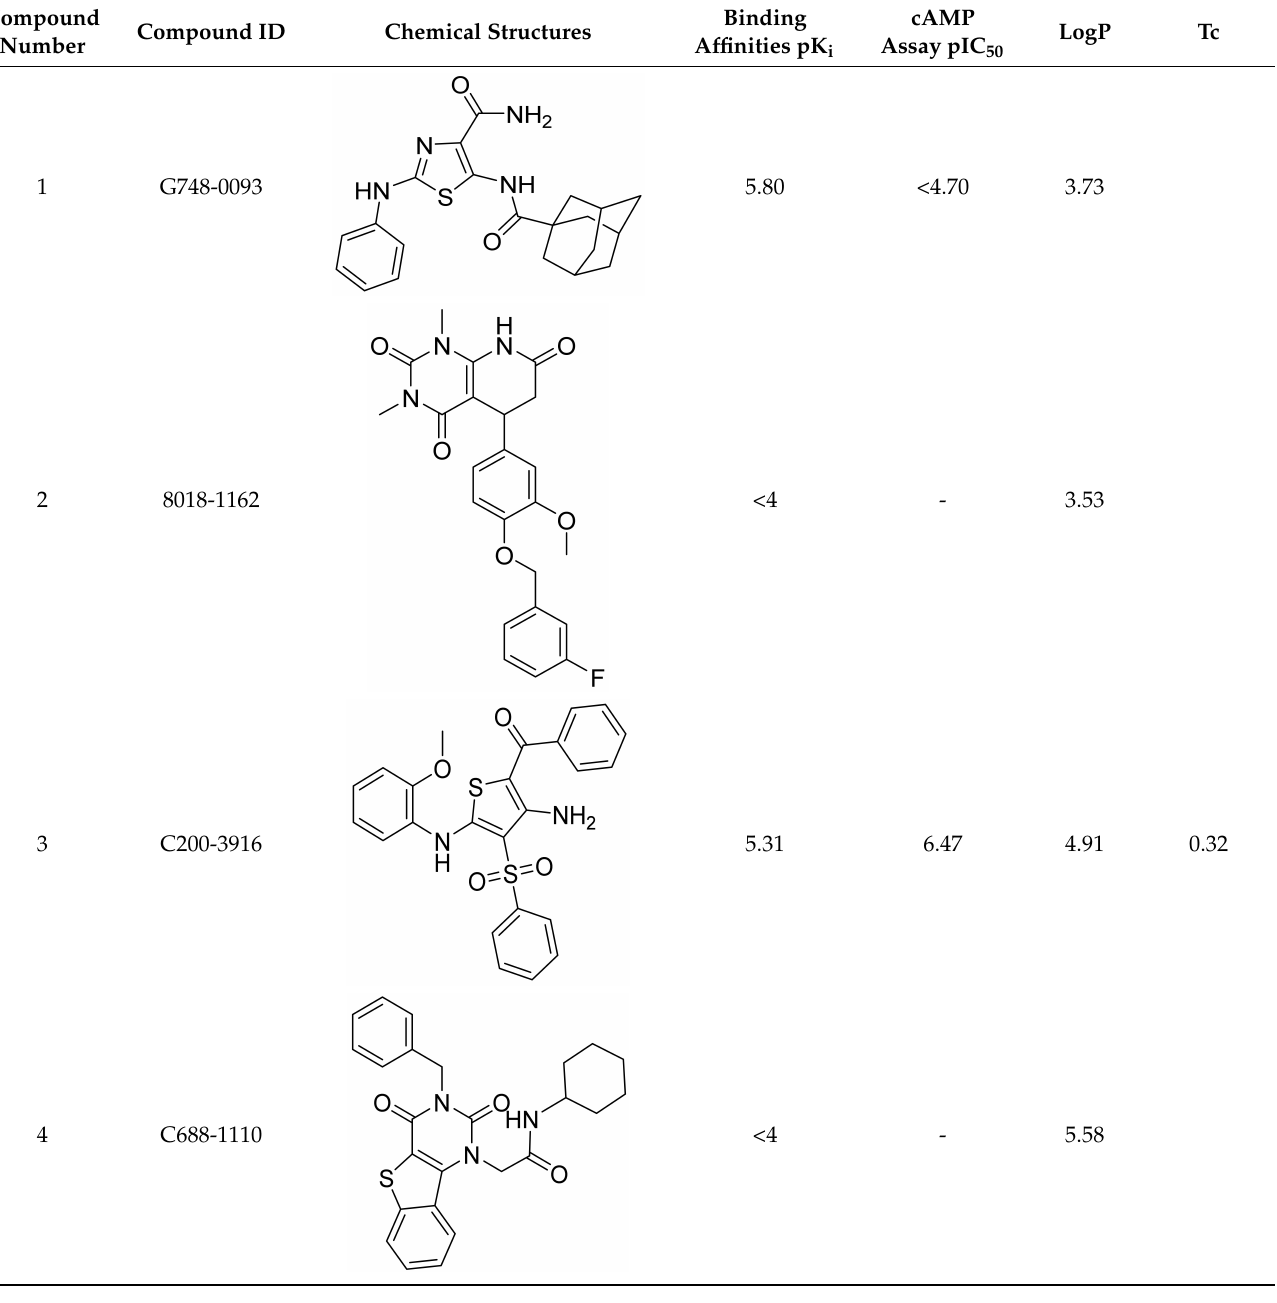
Table 4. The chemical structures, the binding affinities (pK i ) obtained from radioligand binding assays at human CB2 receptor, the potencies (pIC 50 ) at human CB2 receptor, and the Tc values of the 15